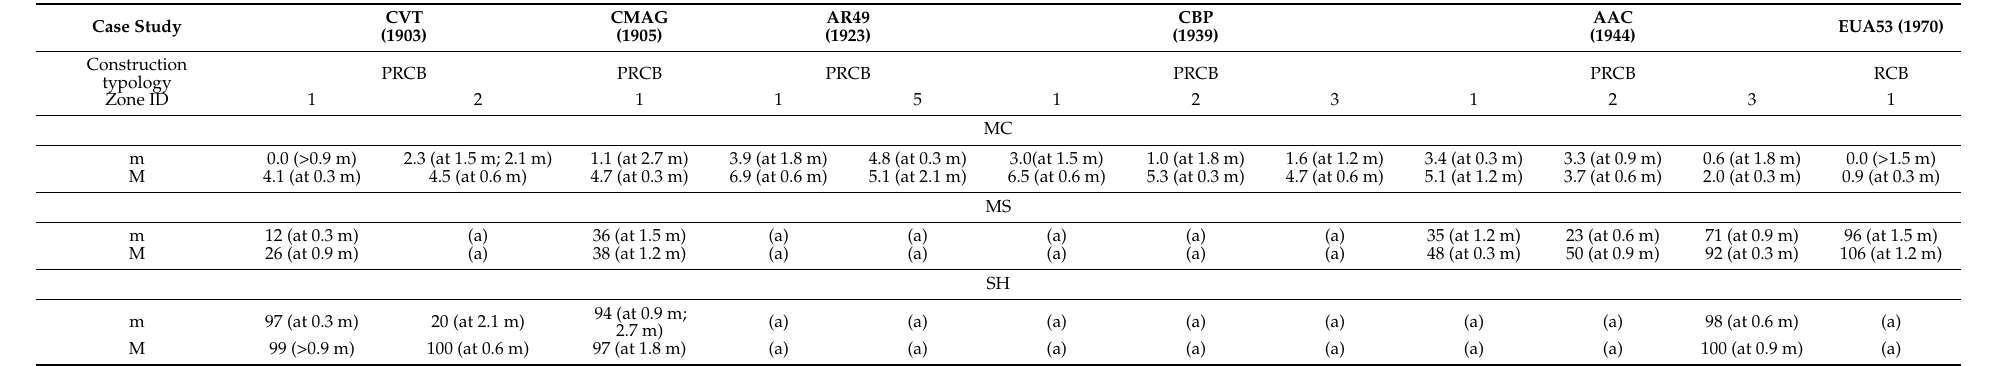
Table 7. Results of in situ tests performed in the zones reported in Table